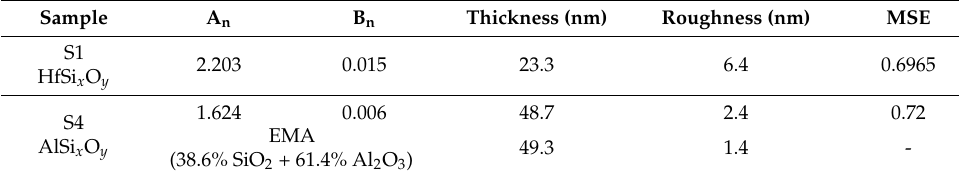
Table 3. Thickness and roughness parameters of silicates layers grown on Si(100) plates.